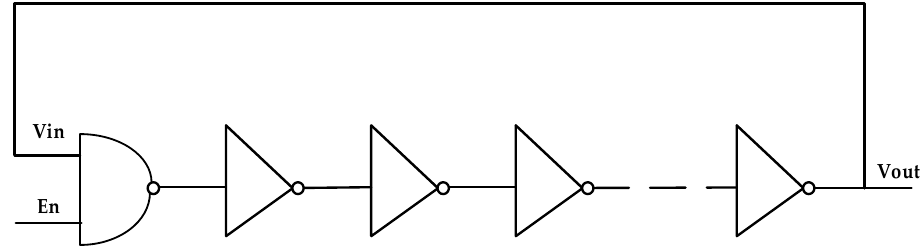
Figure 6. Block diagram of the inverter-based ring oscillator.